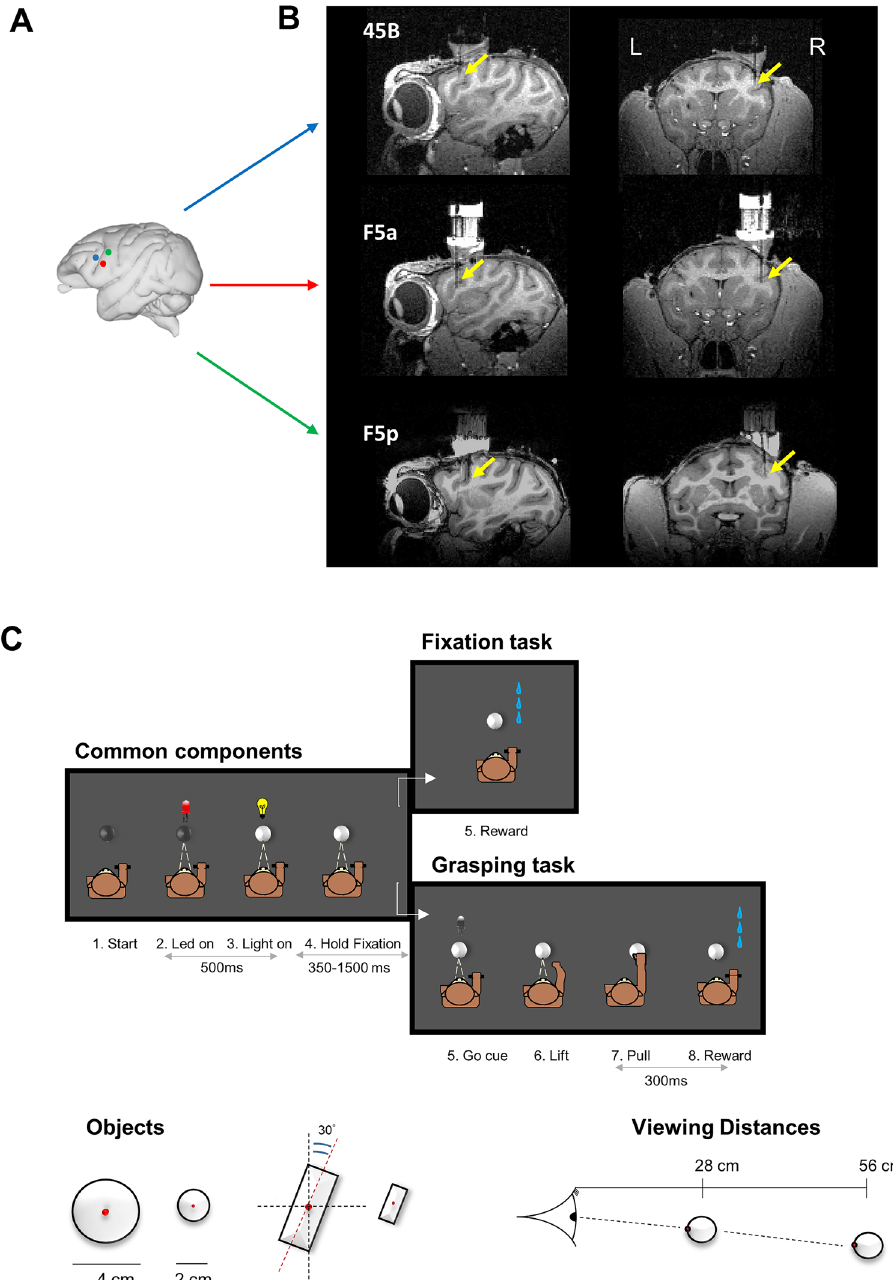
Figure 1. Anatomical location of areas of interest and eye traces. ( A ) Schematic view of a macaque brain (edited from the ‘Scalable Brain Atlas’ http:// link. sprin ger. com/ conte nt/ pdf/ 10. 1007/ s12021- 014- 9258-x). Colored dots represent the areas of interest in the arcuate sulcus, respectively Area 45B—blue, Area F5a—red— and Area F5p—green. ( B ) Anatomical electrode recording position in Monkey D. Yellow arrows indicate the electrode tip location in the three areas. Equivalent recording positions in Monkey Y were reported (data not shown). ( C ). Schematic representation of the behavioral task, stimuli and distances. The first block represents the common events to both Fix and Grasp tasks. The right-upper block corresponds to Fix task, the right-lower represents the Grasp task. Objects: large and small spheres and plates (oriented at 30° from the vertical plane— y-axis; plates size: 5 × 2 cm and 2.5 × 1 cm, respectively). Two viewing distances (Near, Far) from the monkey’s eyes. See details in the